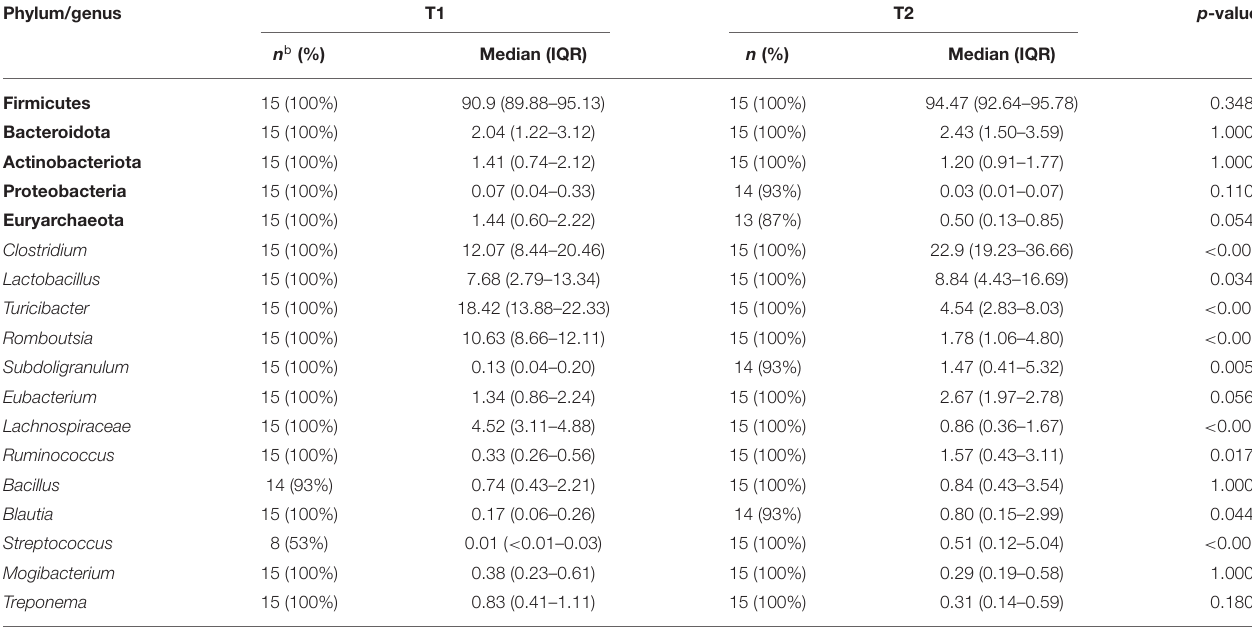
TABLE 5 | Relative frequencies, medians and interquartile ranges (IQR) of the relative abundance (%) of the most abundant bacterial phyla (in bold) and genera (in italics) detected in the T1 and T2 samples. Phylum/genus